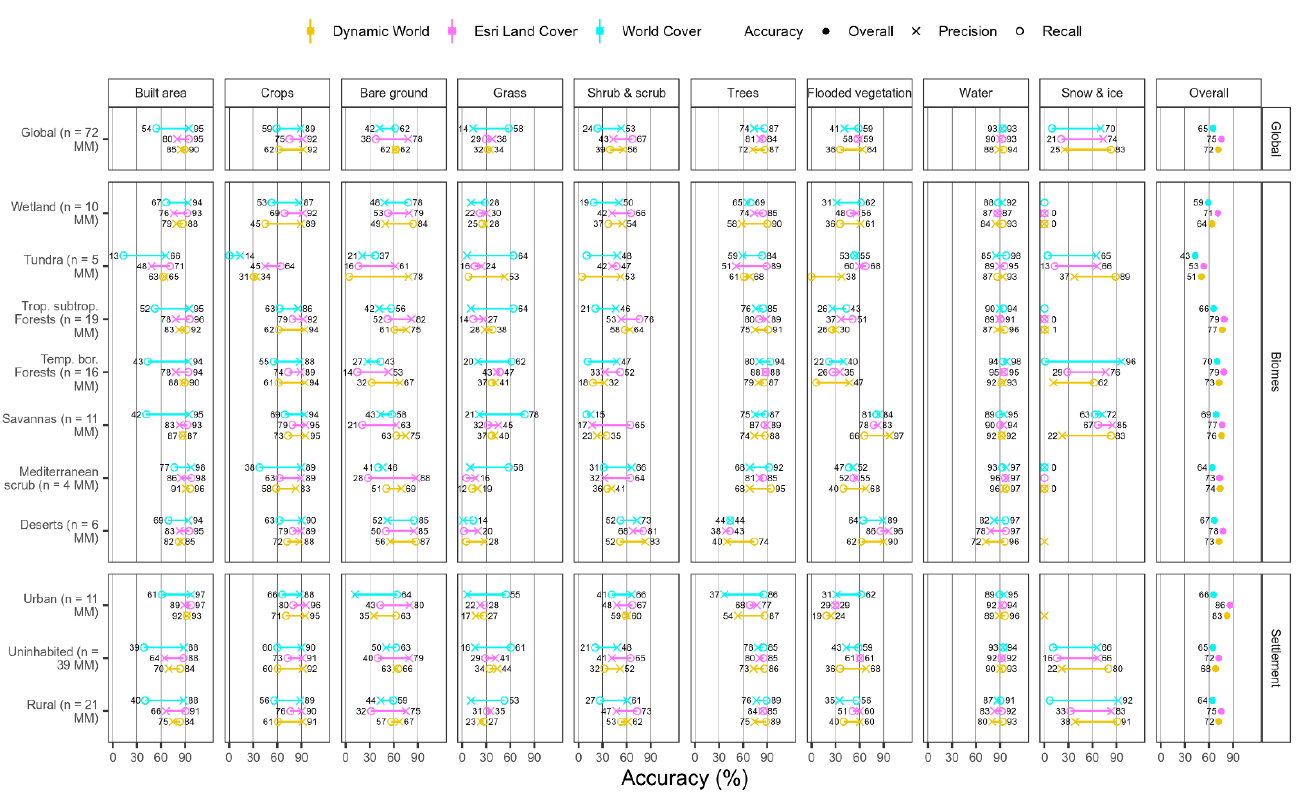
Figure 5. Accuracy of global 10 m land cover maps across LULC classes, biomes and human settle-